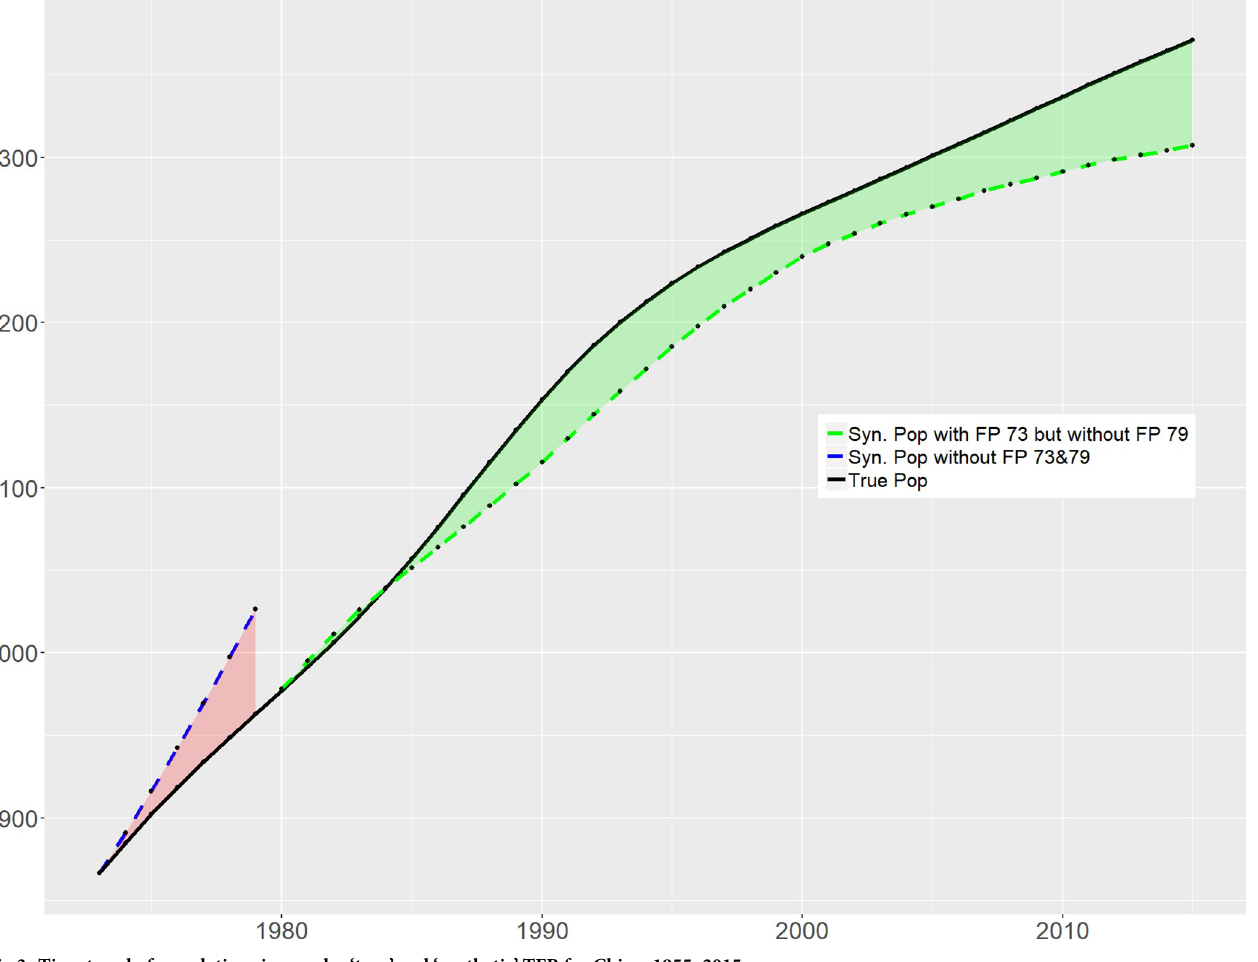
Fig 3. Time trend of population sizes under ‘true’ and ‘synthetic’ TFR for China, 1955–2015.